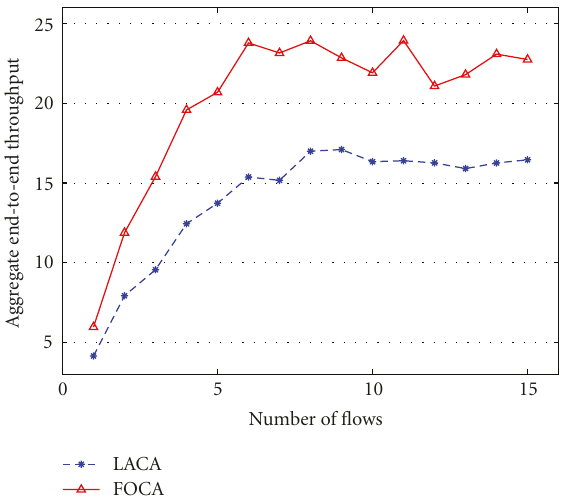
Figure 11: Scalability simulation: aggregate flow rates versus the number of flows. Random networks are of the same size and flows are all 3-hop